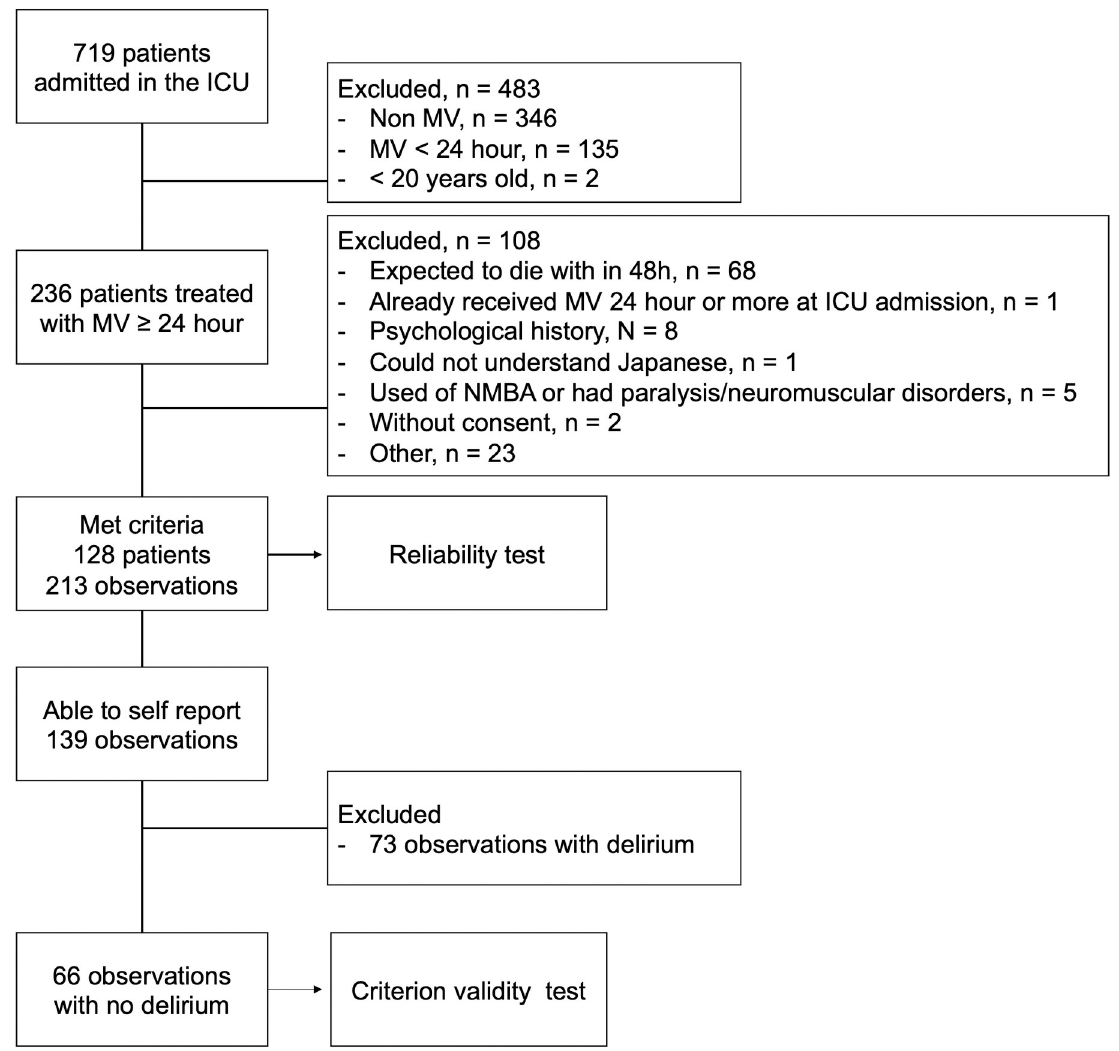
Fig 1. Flowchart of the patient recruitment process. MV, mechanical ventilation; NMBA, neuromuscular blocking agent.